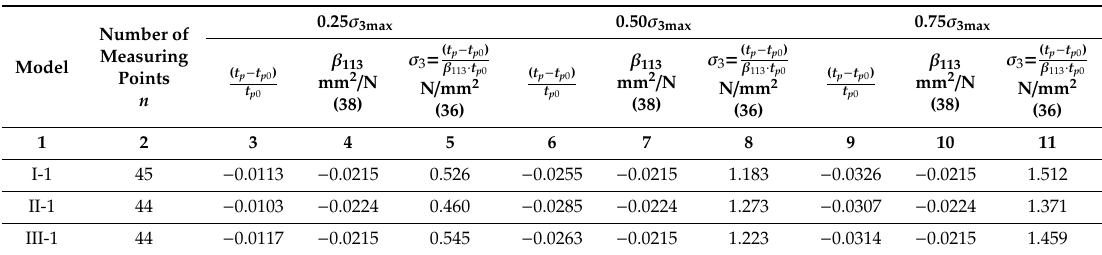
Table 6. Results from calculating normal stress in the wall using a limited number of measuring points.